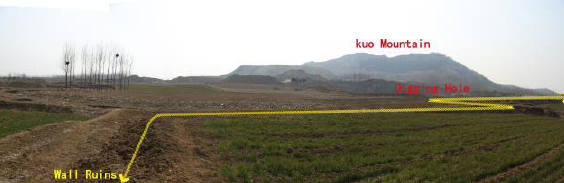
Figure 15. Panoramagram of digging hole in Kuo Mountain